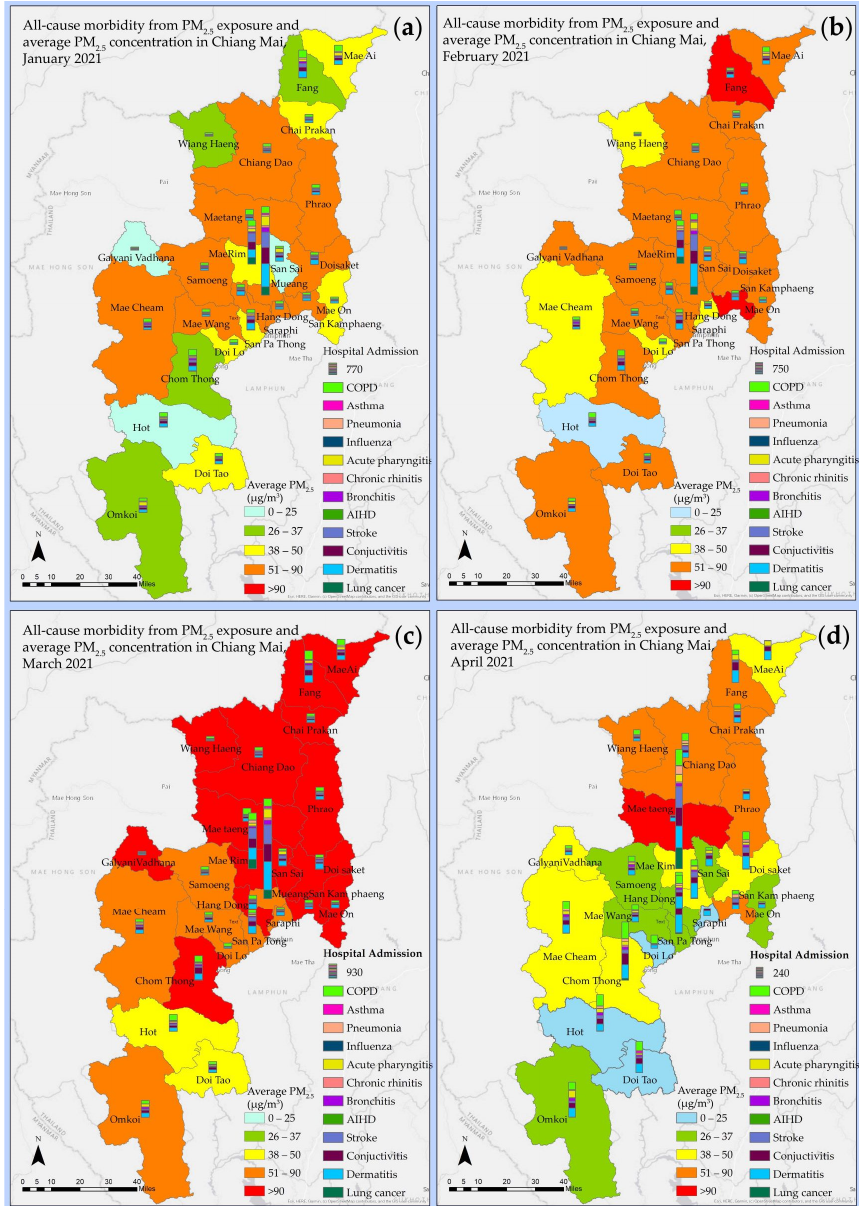
Figure 4. The distribution of PM 2.5 and its health impact in Chiang Mai from January to April 2021 ( a ) in January, ( b ) in February, ( c ) in March, and ( d ) in